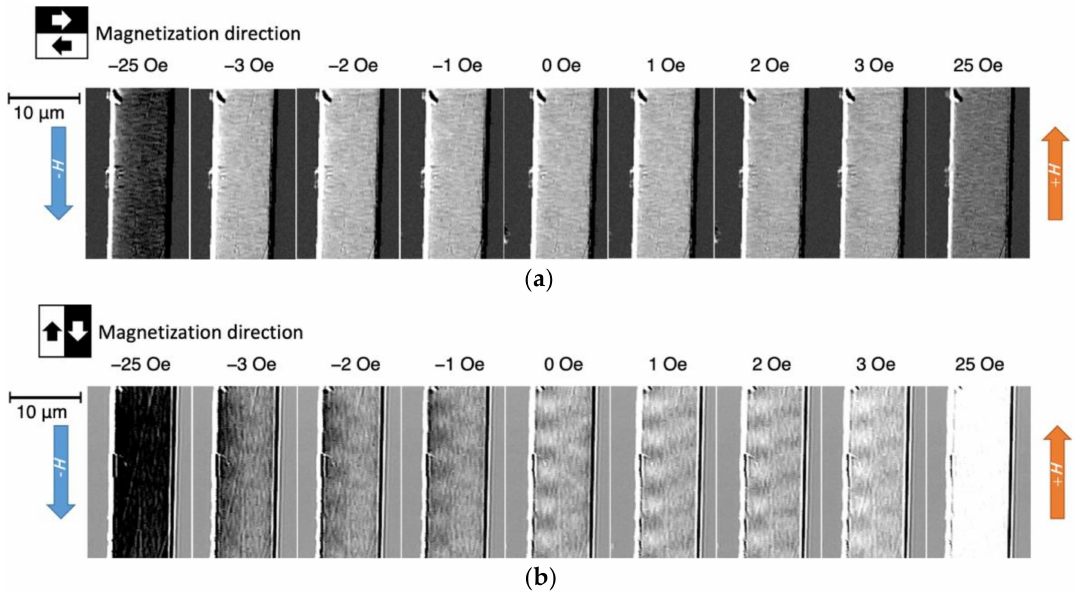
Figure 5. Application of an external magnetic field in the axial direction: ( a ) radial magnetic domain pattern and ( b ) axial magnetic domain